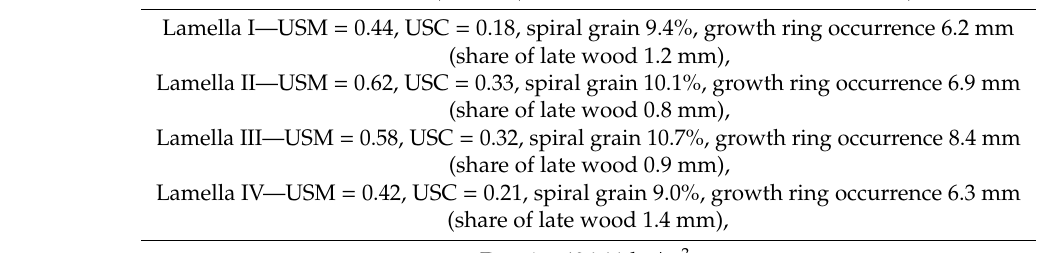
Density 406.11 kg / m 3